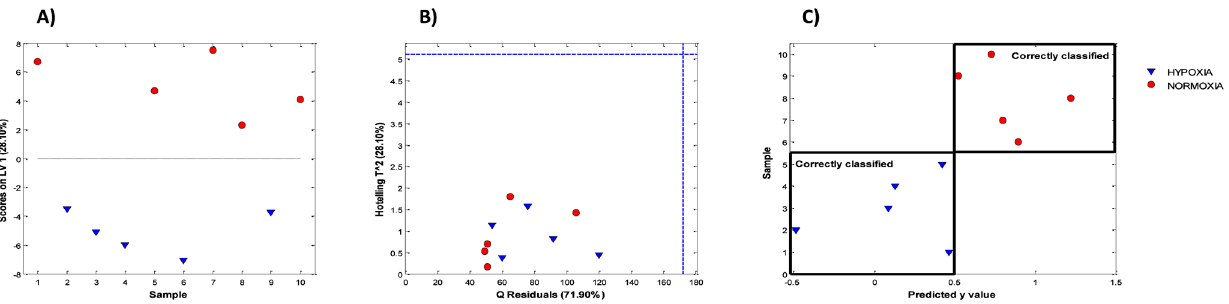
Figure 2. Partial least squares - discriminant analysis of the retina metabolome between normoxic and severely hypoxic newborn piglets. A) PLSDA scores plot; B) residual Q versus the Hotelling’s T 2 statistics; C) PLSDA predicted class labels by double cross validation.